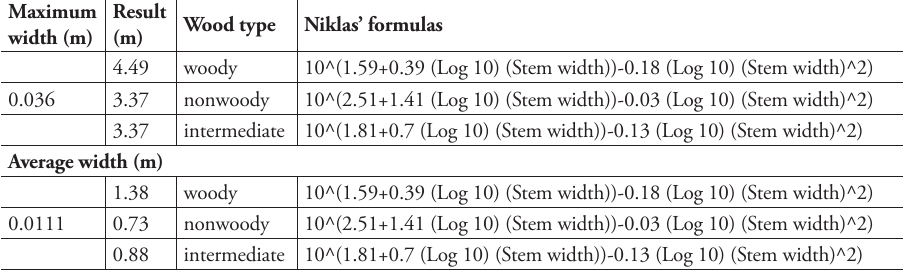
Table 2. Reconstruction of stem